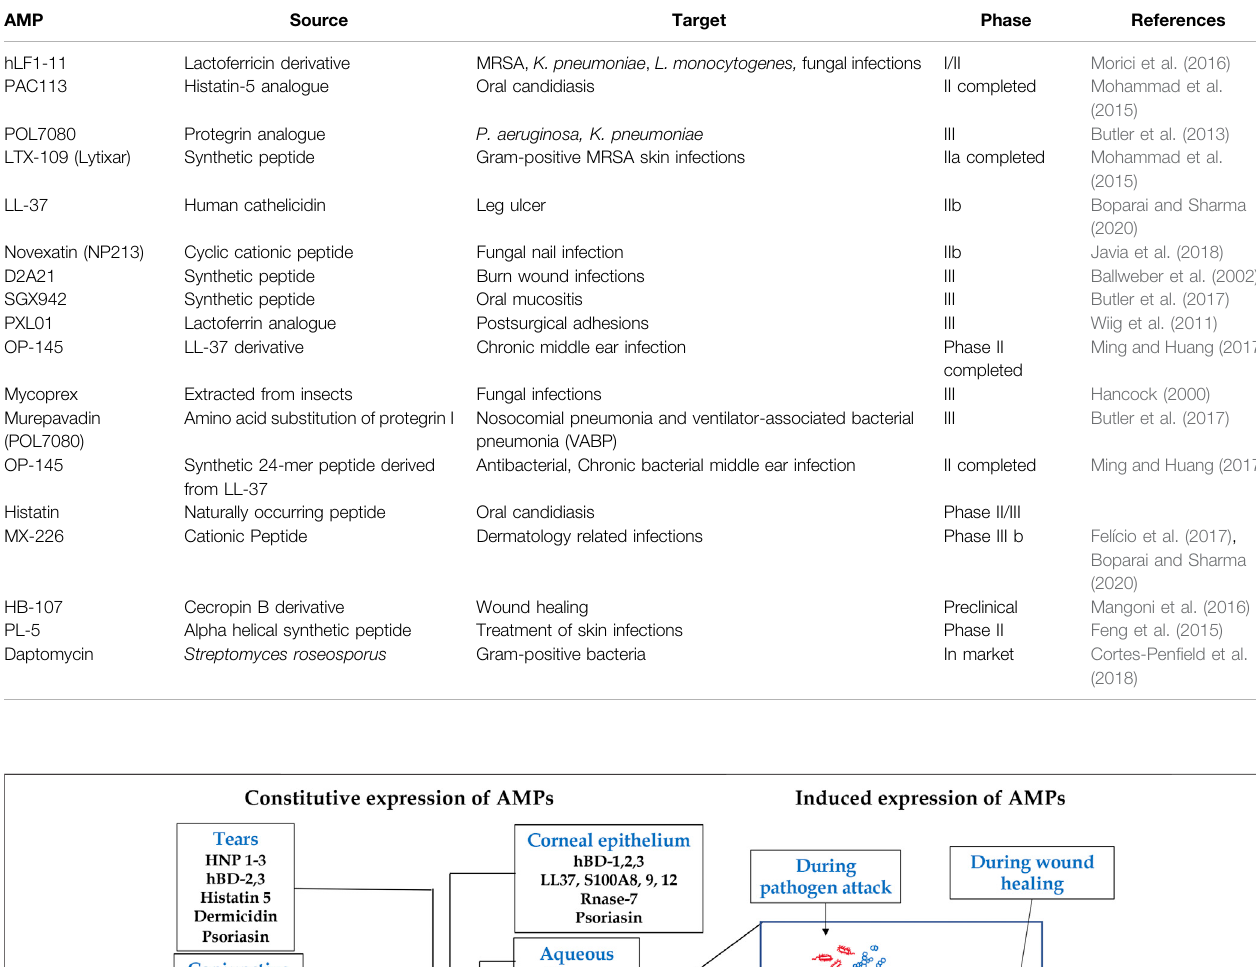
TABLE 1 | Antimicrobial peptides in clinical trial.